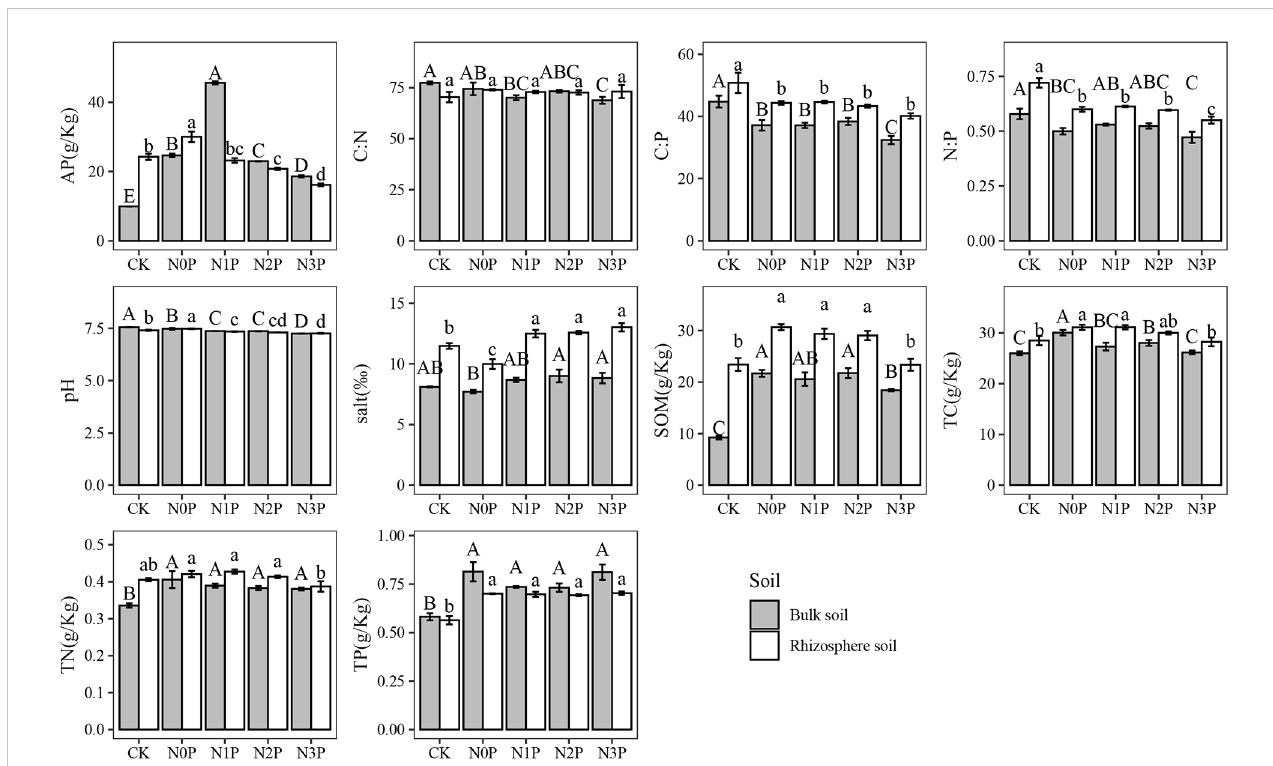
FIGURE 5 The environmental factors in the rhizosphere and bulk soil of S. salsa at different N-P addition ratio treatments. Different capital letters indicate that the difference among N-P addition ratio treatments in bulk soil is signi fi cant (P<0.05) and different lowercase letters indicate that the difference among N-P addition ratio treatments in rhizosphere soil is signi fi cant